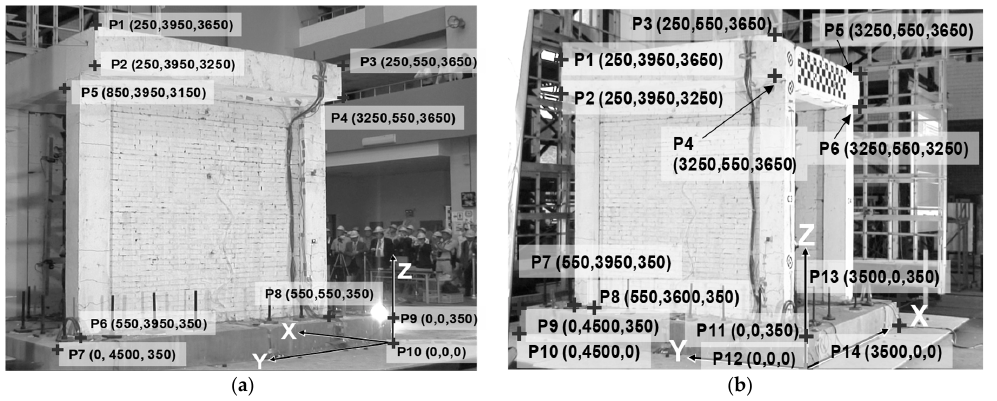
Figure 21. Snapshots of the two cameras and selected calibration points. ( a ) Left camera. ( b ) Right camera.